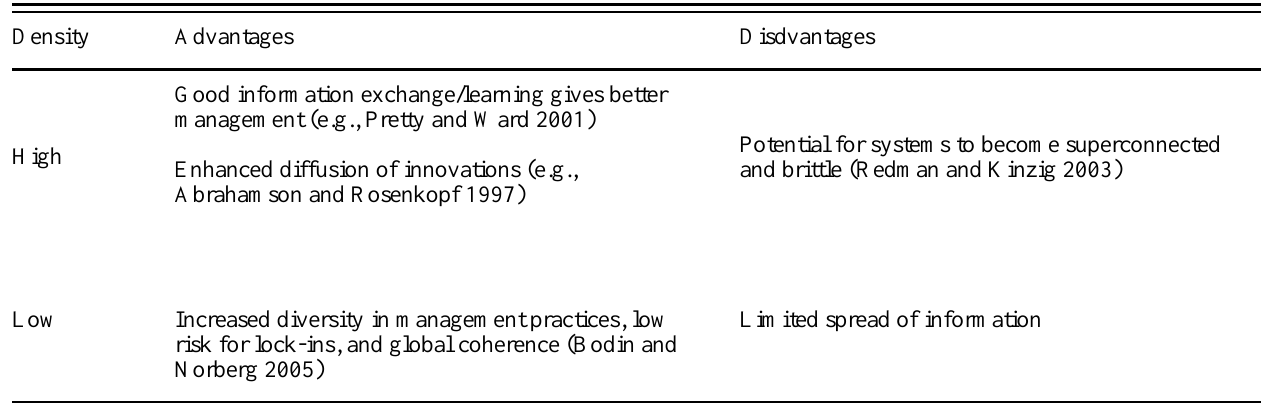
Table 1 . Sensitivity of the performance of a system to differences in density.